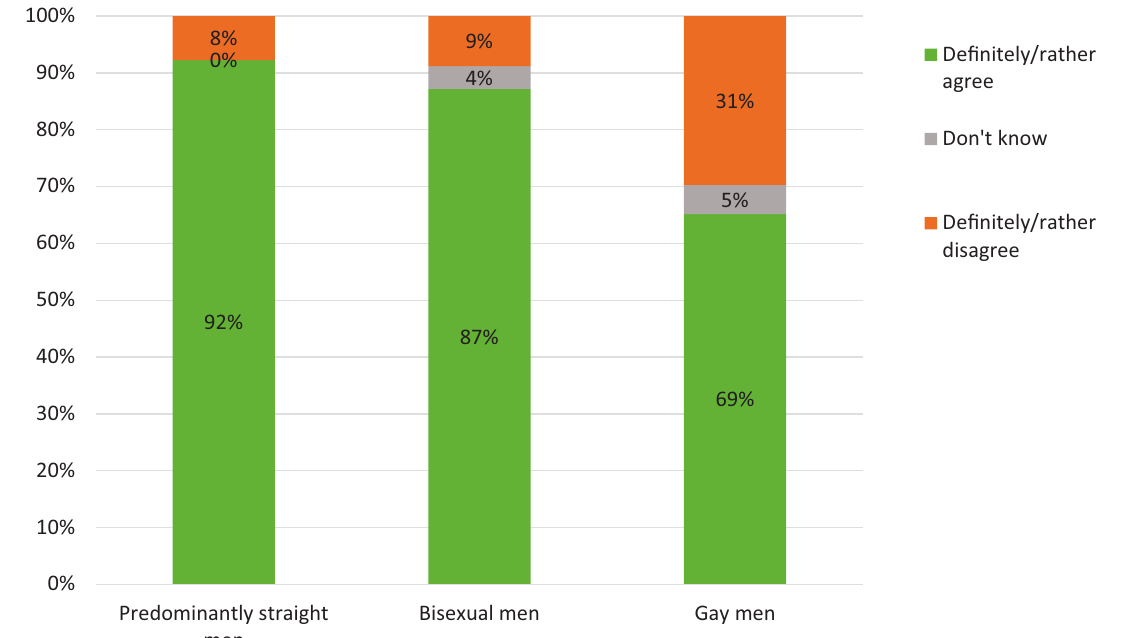
Figure 3. Perceived freedom to decide whether to become a parent, by men’s sexual identities; percentages were calcu‐ lated based on answers to the question: Would you say, about yourself, that you are free to decide whether to become a parent? Note: Chi‐square test is statistically significant (Sig. =